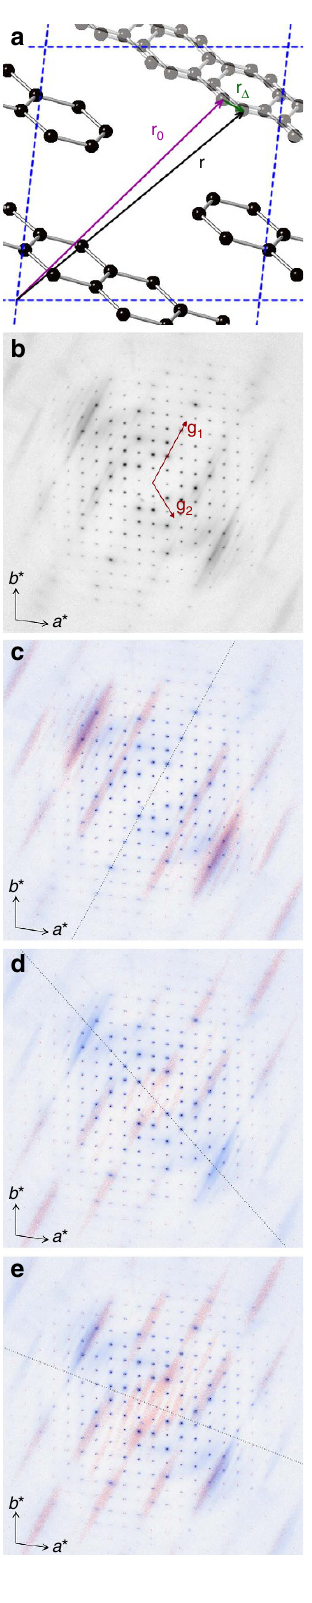
Figure 3 | Analysis and simulation of TIPS-P diffraction pattern. ( a ) Structure of TIPS-P with real space vector r ¼ r 0 þ r D describing the position r of a single carbon atom in its unit cell as superposition of its equilibrium position r 0 and thermal displacement r D . ( b ) Experimental diffraction pattern of TIPS-P from Fig. 1a, corrected for its noise background to better contrast the streak intensity. The missing (000) reflection is an artefact of the background correction due to the high intensity drop-off close to the centre of the diffraction pattern. ( c – e ) Simulated diffraction patterns with the conjugated pentacene cores displaced parallel to its long axis ( c ), along its short axis ( d ), in p – p stacking direction ( e ). The simulated diffraction patterns (red) are laid over the experimental diffraction patterns (blue) for easier comparison. The dotted line indicates the direction perpendicular to the modelled molecular displacement r D